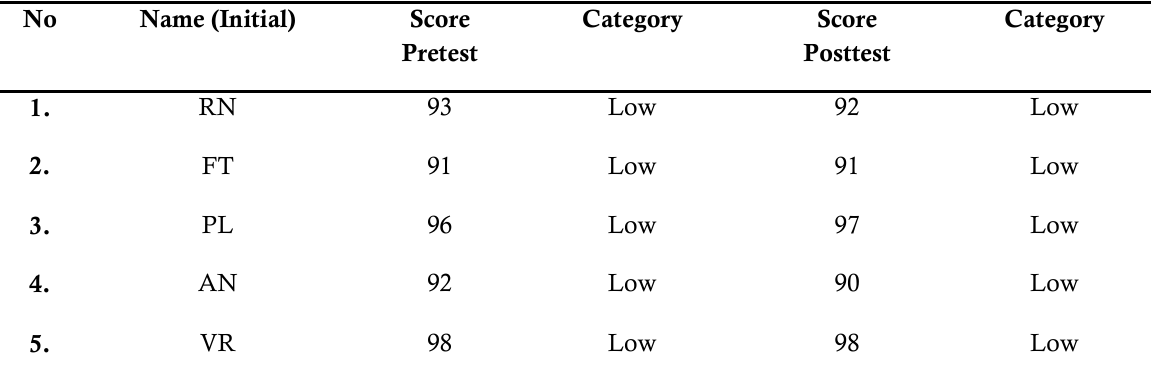
Table 2. Pretest and Posttest Results of Social Skills of the Control